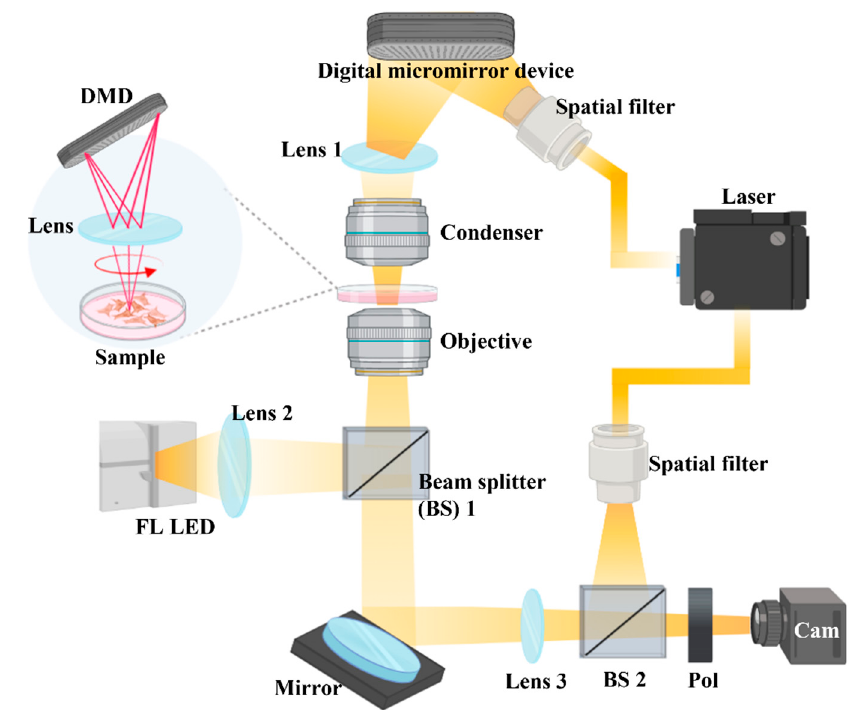
Figure 5. 3D-ODT device. A 3D-ODT device was used to capture 3D images of LDs in the cisplatin group and α -LA group. With a Mach–Zehnder interferometric microscope with an integrated digital micromirror device, 2D holograms were captured from various angles of illumination, and the RI distributions of these holograms were reorganized to obtain 3D-phase images.